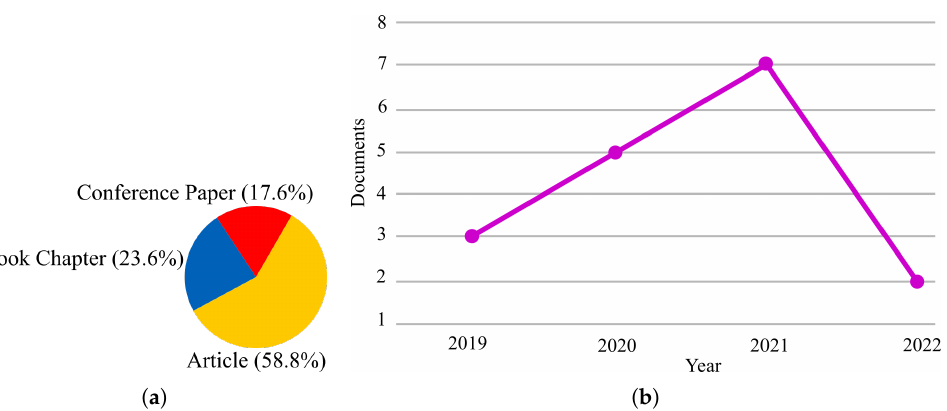
Figure 3. Search statistics extracted from Scopus related to the application of SI in IoMT: ( a ) per publication type, ( b ) per